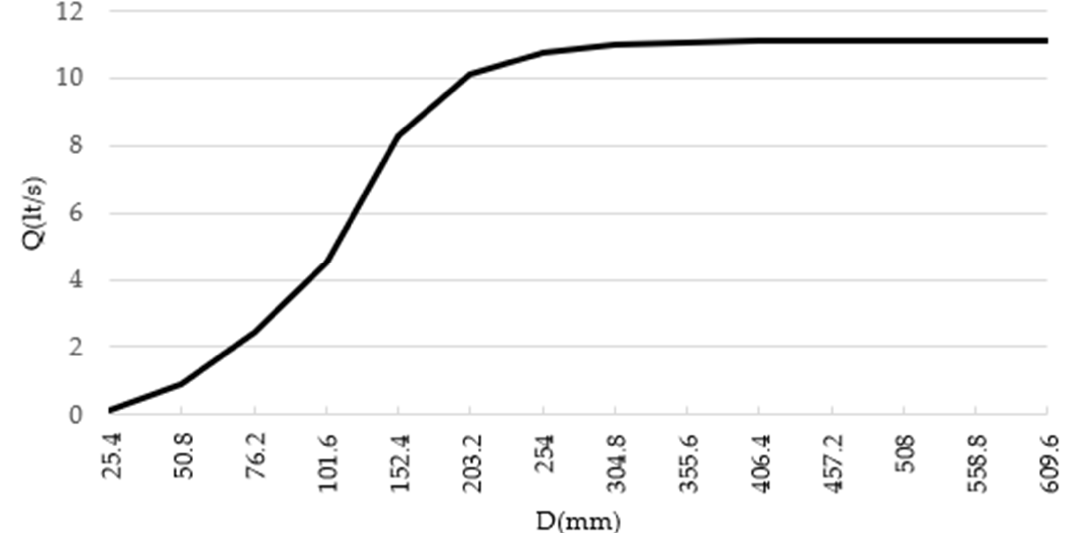
Figure 3. Change in flow rate of pipe 8 in the two-loop network.